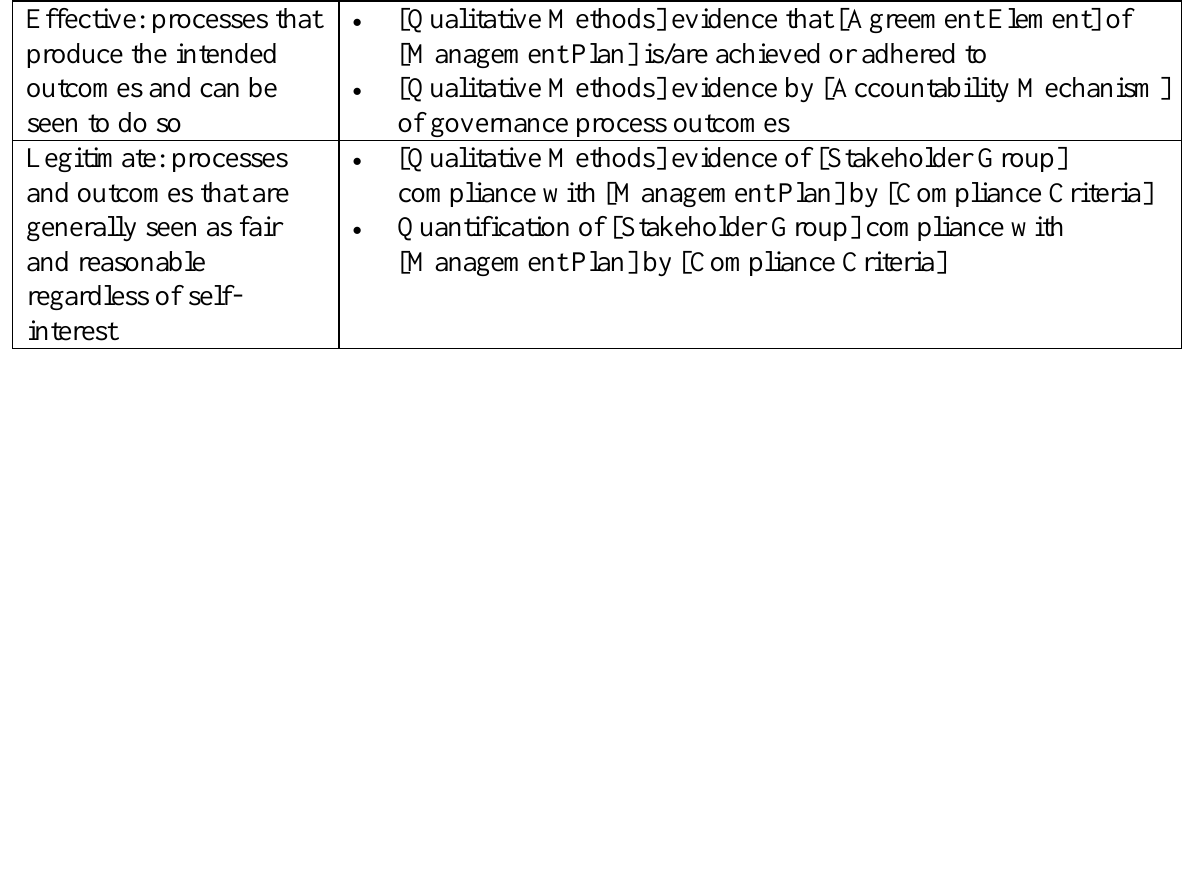
Table A1.3: Outcomes Dimension – Example Indicators Element Example